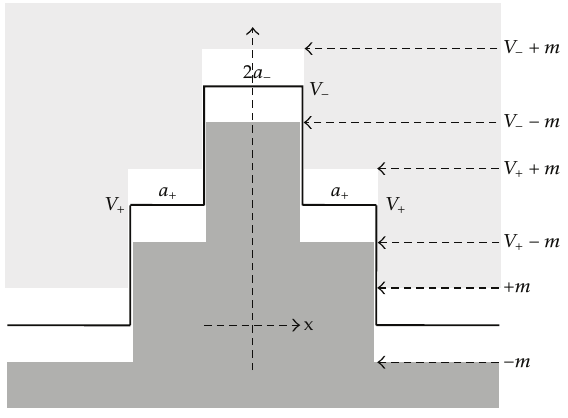
Figure 6: The potential configuration with V (cid:2) > 2 m and V − > V (cid:2) (cid:2) 2 m .